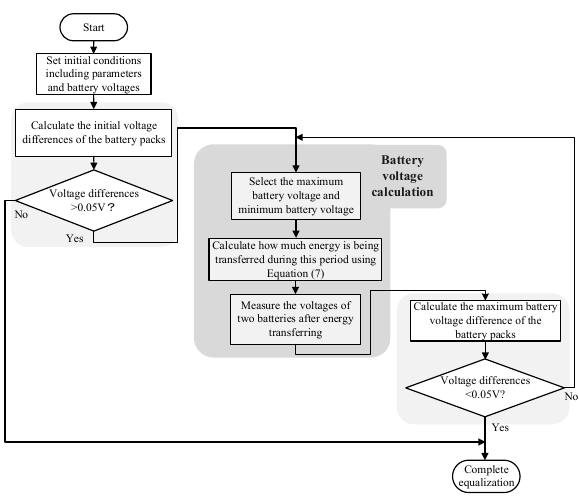
Figure 16. Flowchart of the single SC-based BE.